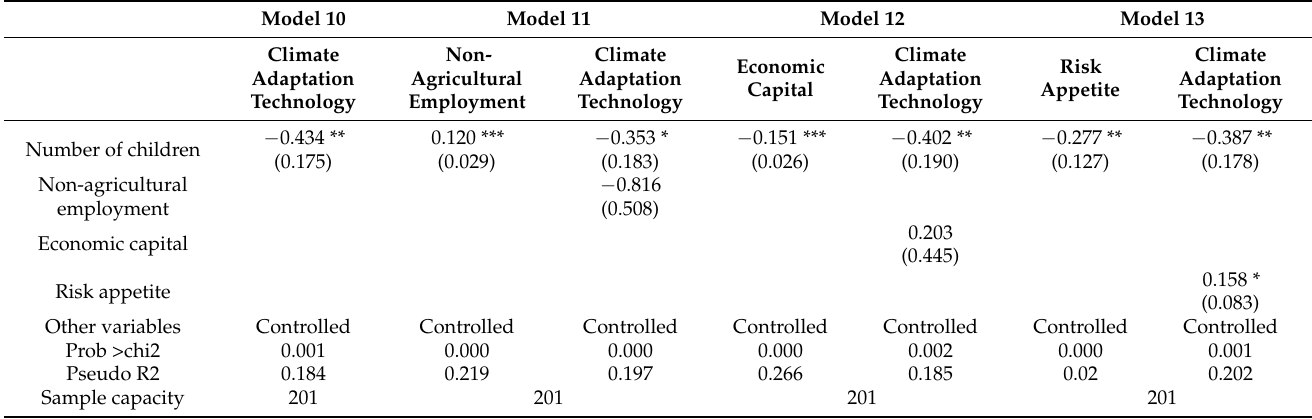
Table 7. Test of influencing factors and action mechanism of farmers’ climate adaptive technology in burden